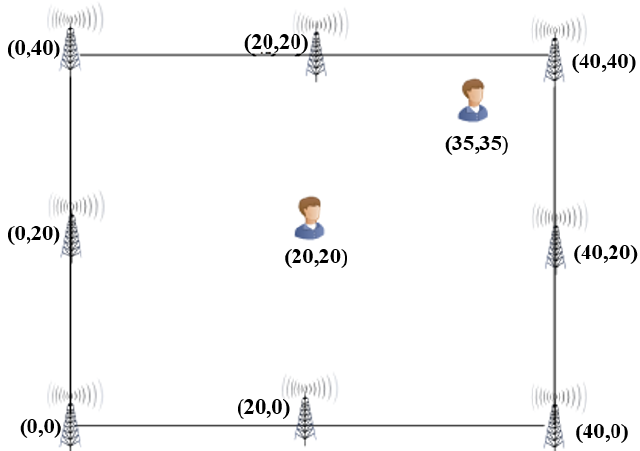
Figure 12. Distribution of sensors and emitter scenario [82].